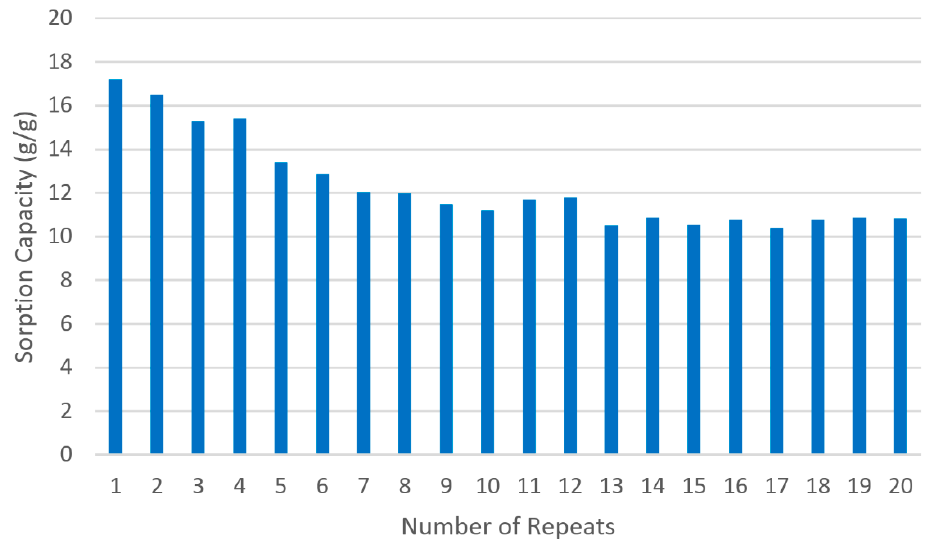
Figure 9. Recyclability test for functionalised cigarette filters using motor